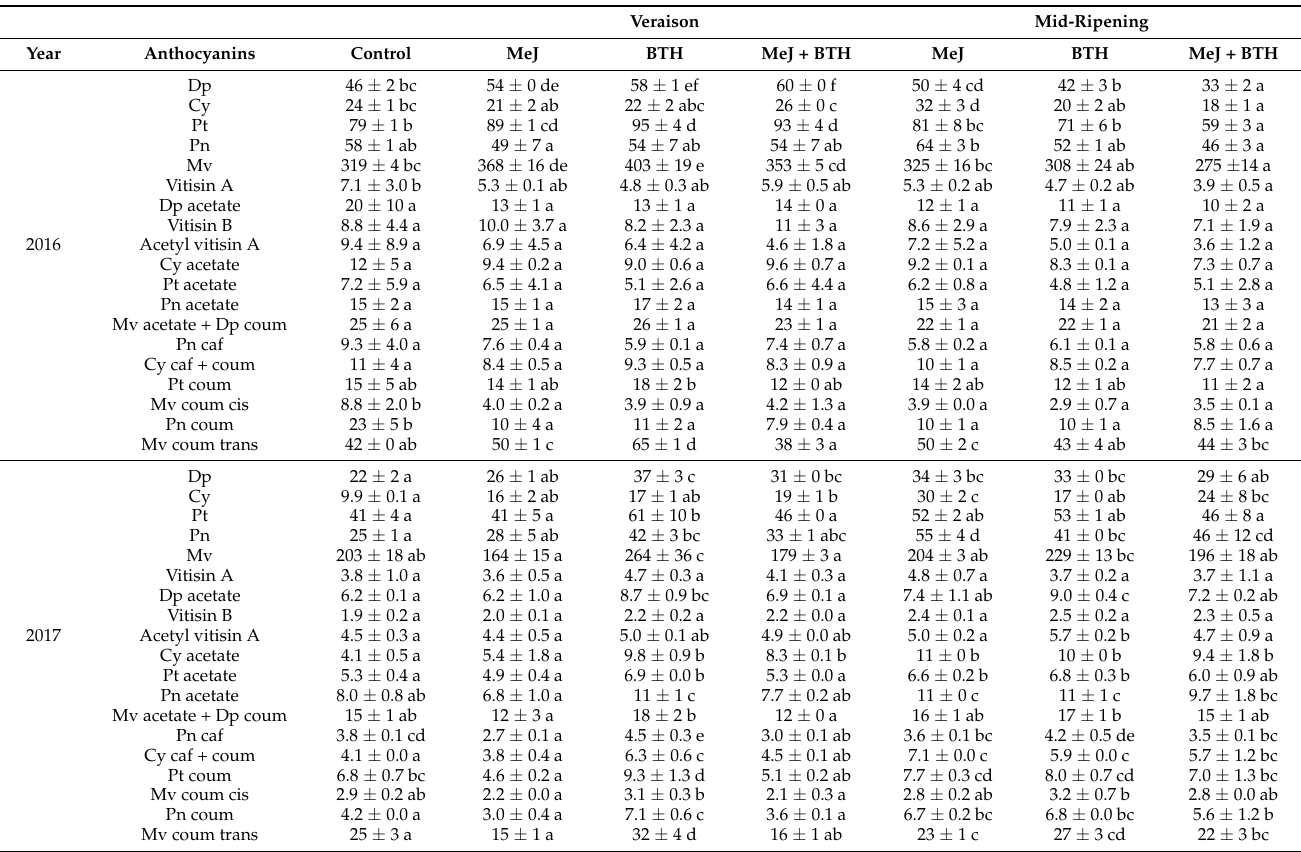
Table 3. Concentration of anthocyanins expressed as mg/L at the end of alcoholic fermentation in Monastrell wines (2016 and